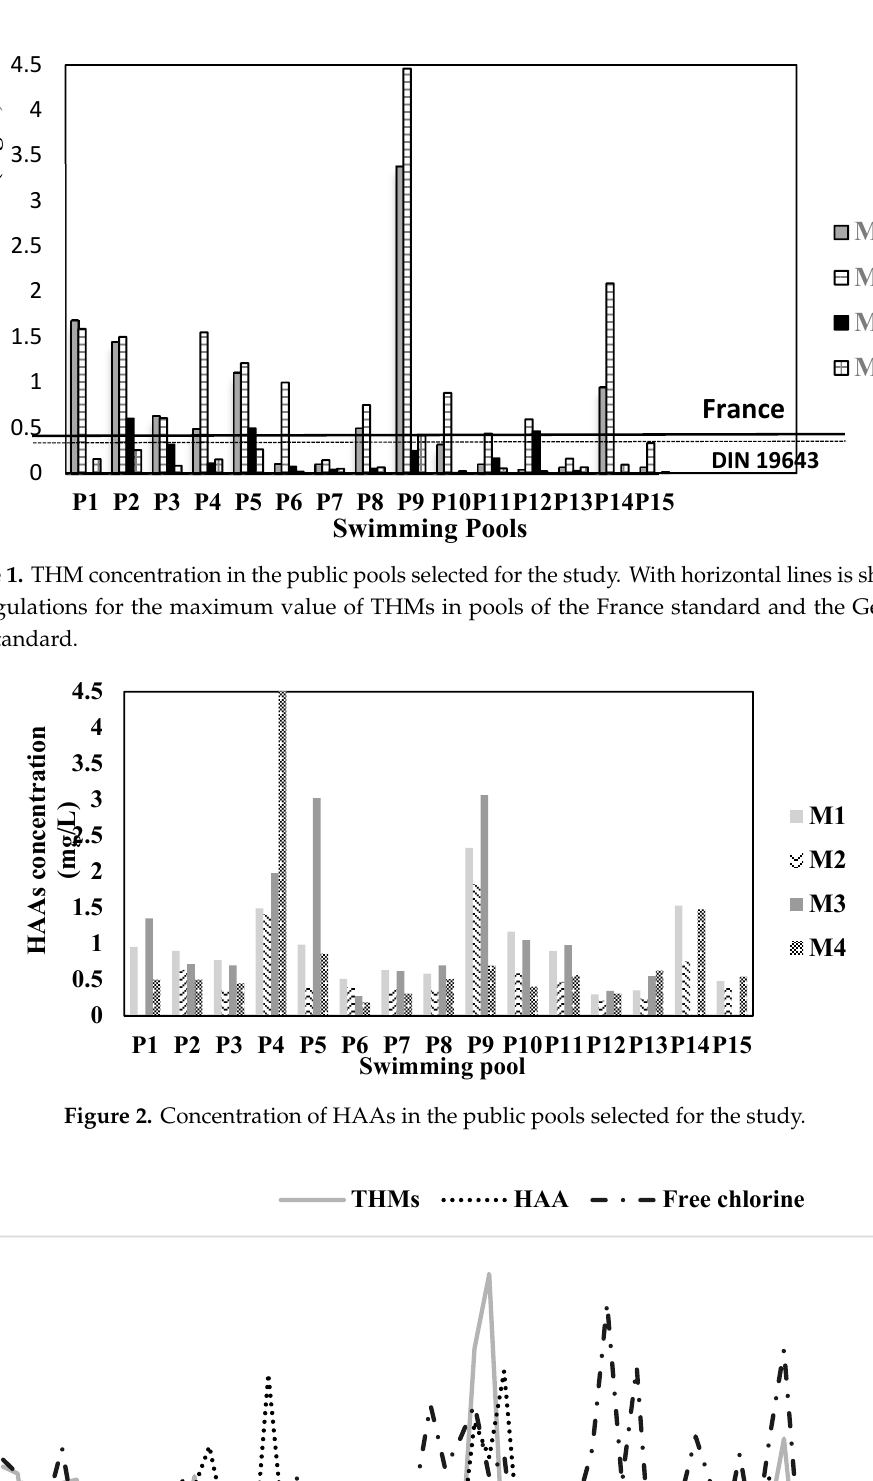
Figure 3. Residual free chlorine in the public pools selected for the study when sampled for the measurement of THMs and HAAs.